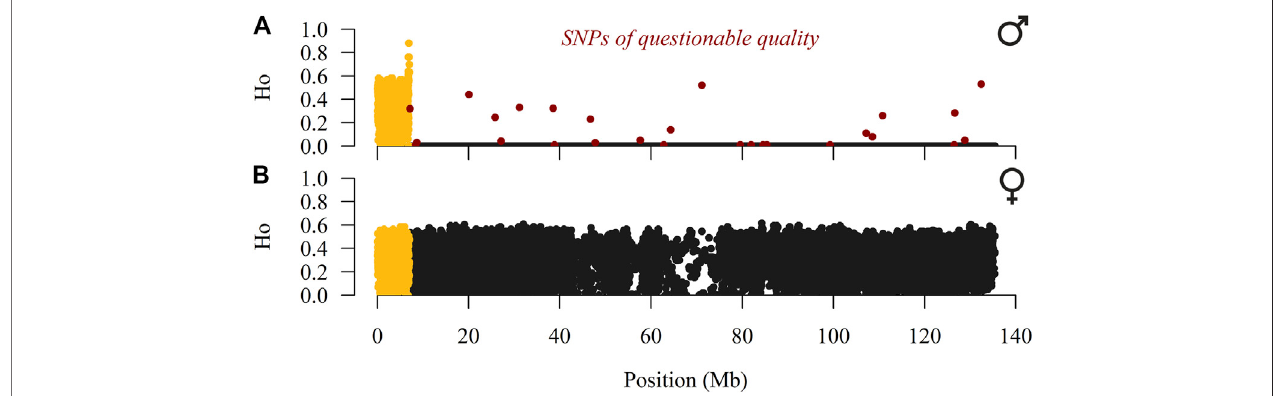
FIGURE1| Observedheterozygosity(H O )ofmale (A) andfemale (B) individualsofSNPsplacedovertheX-chromosome(pseudo-autosomalSNPsarecolouredin yellow) in the East Adriatic sheep